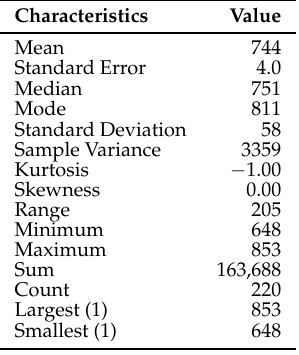
Table 6. Statistical characteristics of revolutions’ speed.